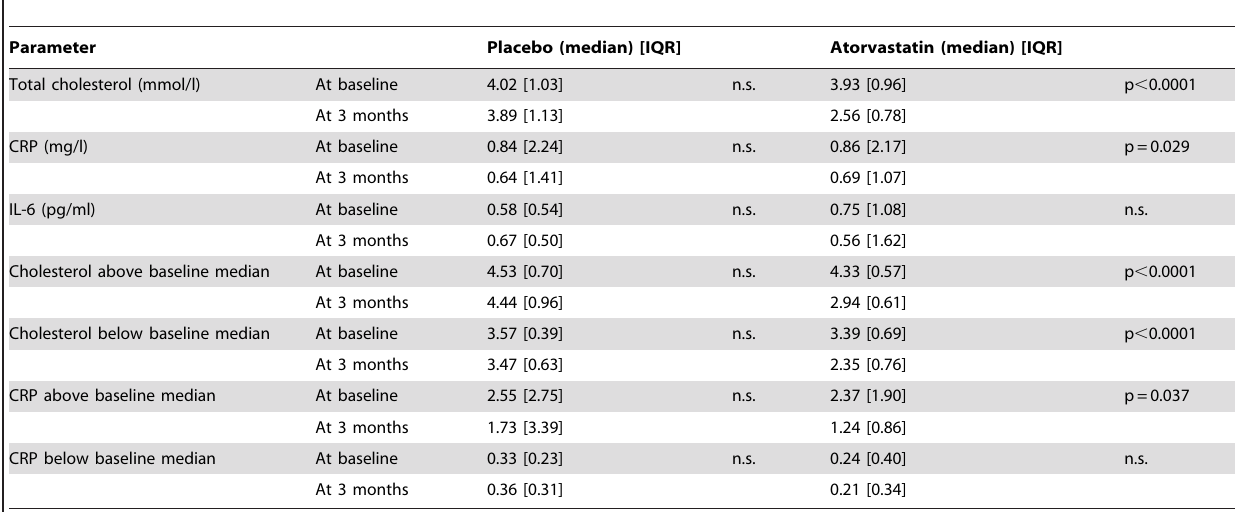
Table 2. Effect of atorvastatin treatment on levels of cholesterol and immune mediators.